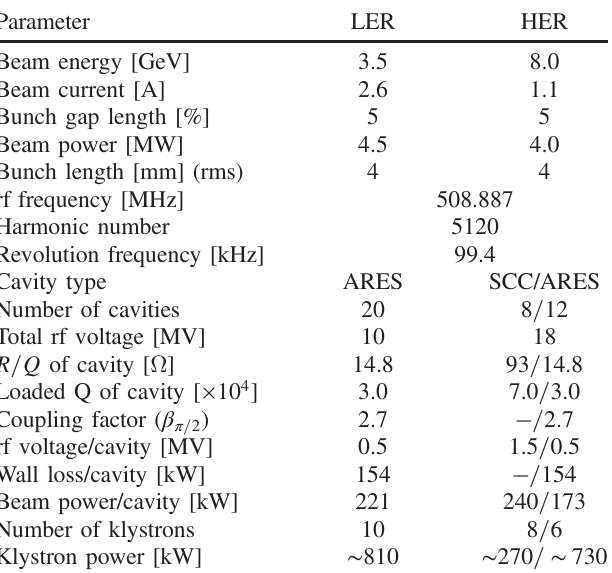
TABLE I. rf-related design parameters of KEKB. Parameter